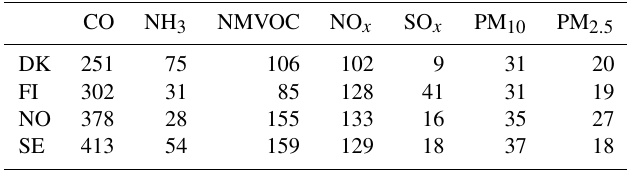
Table 1. Total pollutant emissions in the Nordic countries (in Gg) in 2015.